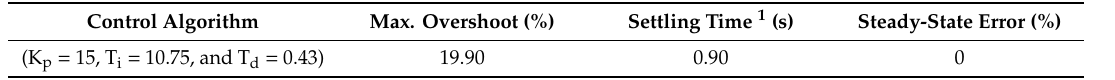
Table 2. The response of the PID coe ffi cients considering viscosity. Control Algorithm Max. Overshoot